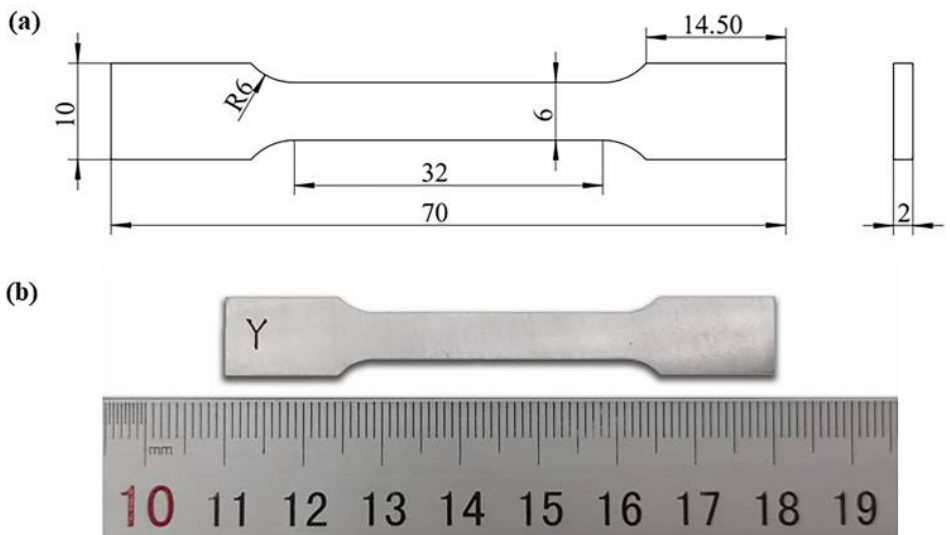
Figure 4. ( a ) Dimensions of the tensile test sample (mm) and ( b ) the image of the polished coupon.